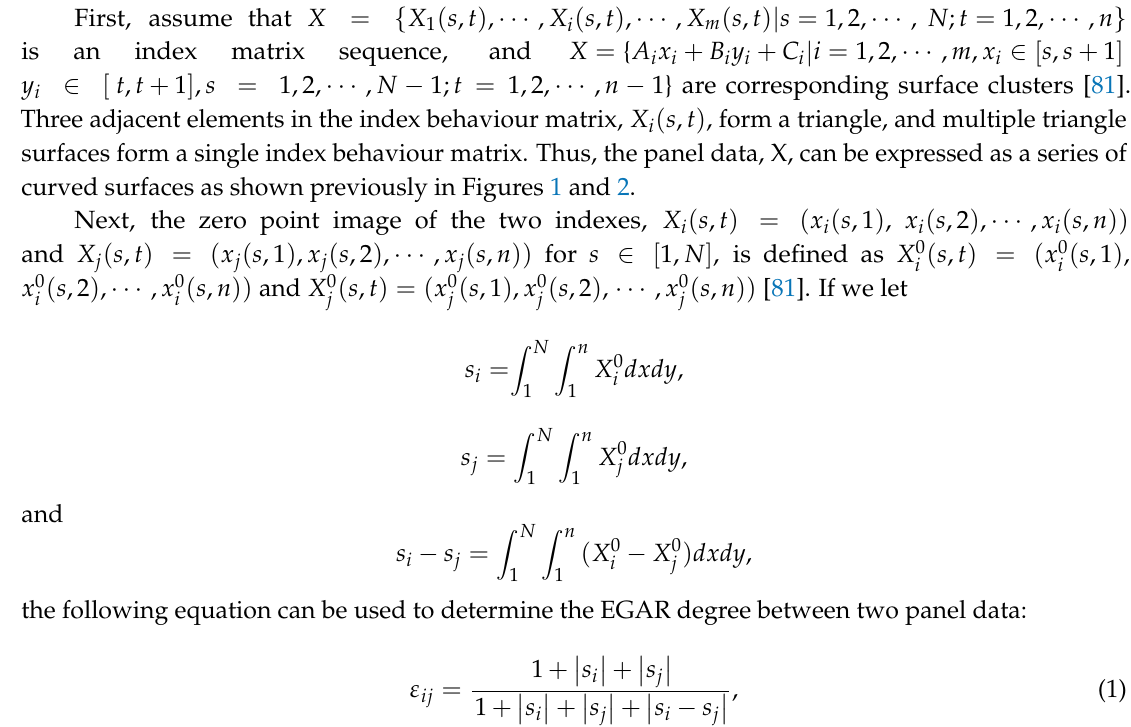
Figure 2. EGAR model panel data curved surfaces using different connections. The pink plane is generated by linking the panel data points of research object and the yellow plane is generated by linking the panel data points of another research object with another style.